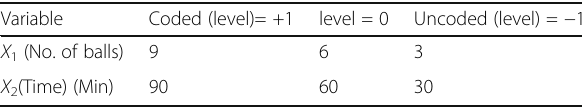
Table 1 Translation of coded labels into the actual